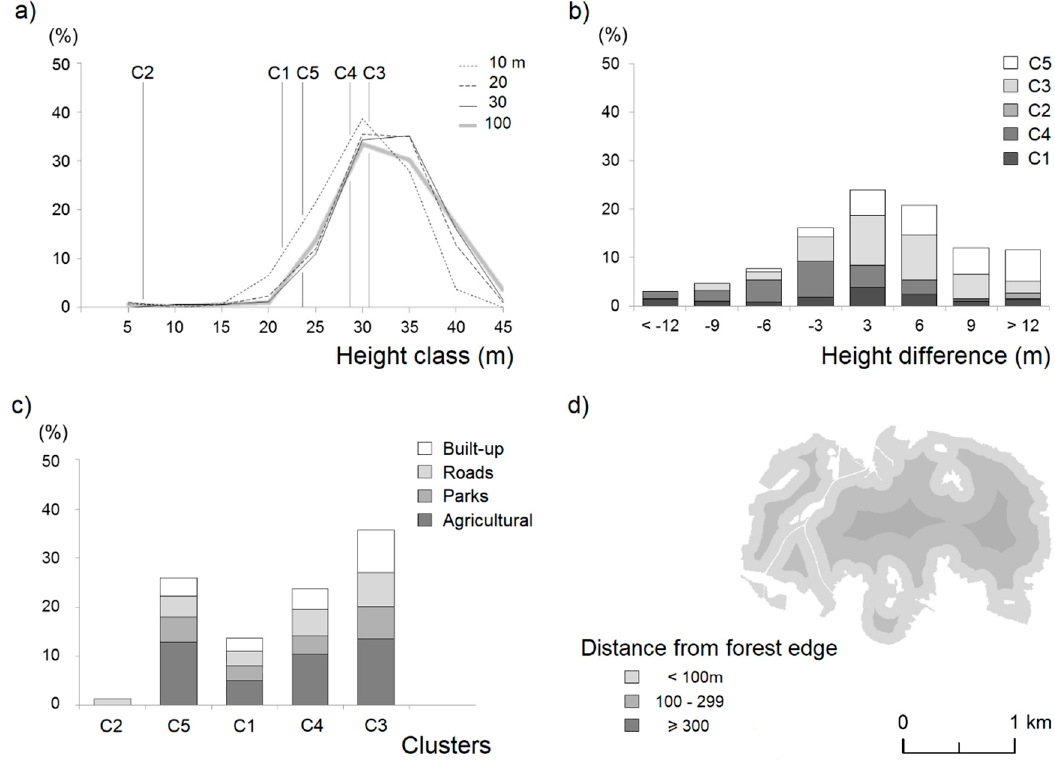
Figure 6. The proportion of canopy cover at di ff erent height levels of trees ( a ); height di ff erences between the tallest trees in the first and second forest edge belts ( b ); and the lands bordering on the forest edge ( c ); in the area of the Rožnik forest patch ( d ).